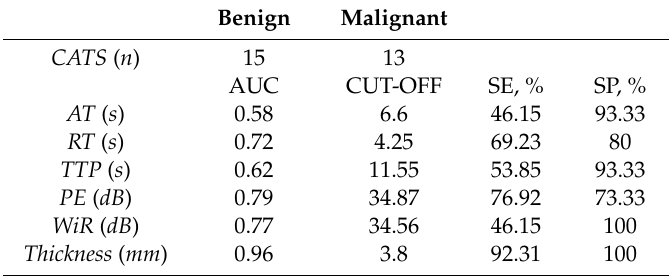
Table 6. Parameters calculated from Receiver Operator Characteristics (ROC) curves of B-mode and CEUS quantitative values for discrimination between “benign” and “malignant” groups.